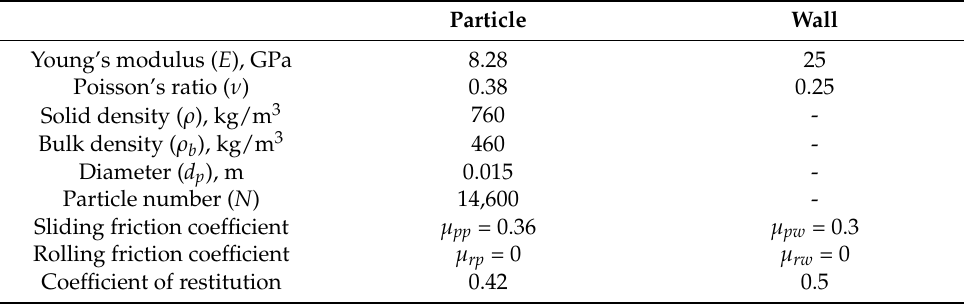
Table 1. Basic material